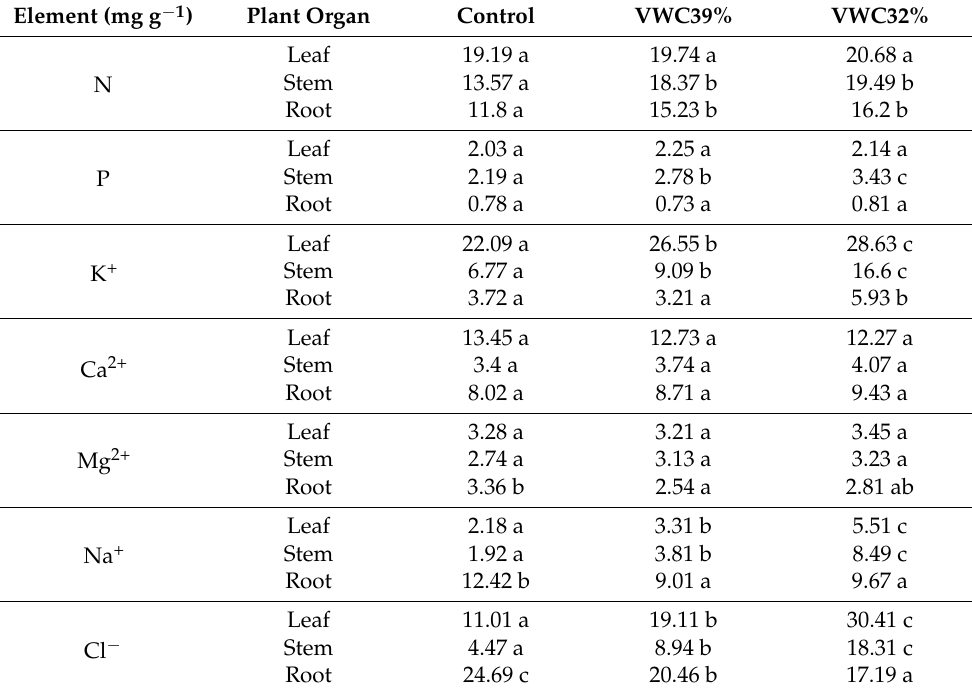
Table 5. Plant macronutrient (N, P, K + ) and mineral content (Ca 2+ , Mg 2+ , Na + , Cl − ) in leaves, stems, and roots of Hebe at the end of the experiment. Control, VWC39%, and VWC32% denote Hebe plants grown over 152 days at 49.28%, 38.44%, and 32.16% VWC, respectively. Element (mg g − 1 ) Plant Organ Control N